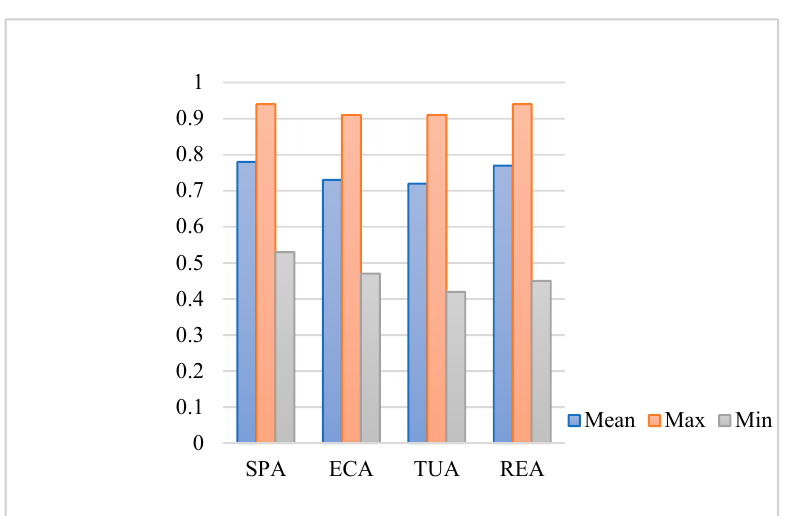
Figure 3. Ecosystem health level in functional divisions of Shennongjia National Park. (SPA, ECA, TUA and RDA are abbreviations of Strictly Protected Areas, Ecological Conservation Areas, Tradi- tional Use Areas and Recreational Exhibition Areas, respectively.).